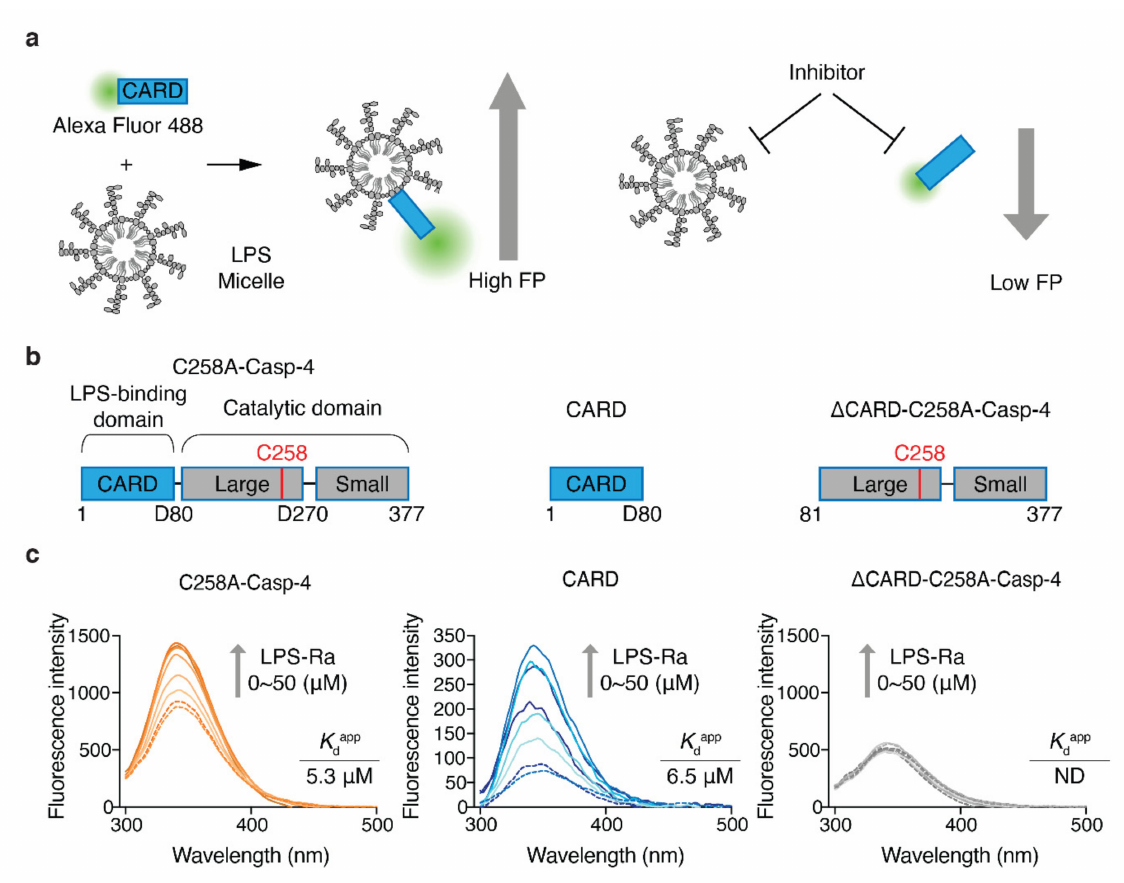
Figure 1. Design of an FP-based assay to monitor and screen inhibitors of the LPS–CARD interaction. ( a ) Schematic diagrams of an FP-based assay to monitor LPS/CARD binding and the effects of inhibitors. ( b ) Schematic domain structures of C258A-Casp-4, CARD, and ∆ CARD-C258A-Casp-4. ( c ) Intrinsic Trp emission spectra of full-length C258A-Casp-4 (four Trp residues), CARD (one Trp residue), and ∆ CARD-C258A-Casp-4 (three Trp residues) in the presence of varying concentrations of LPS-Ra (0–50 µ M). The data are representative of three independent